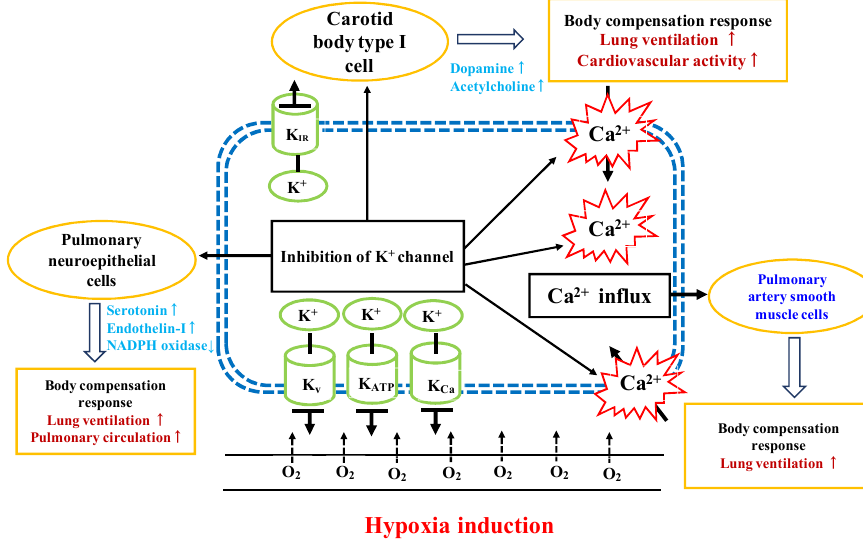
Figure 5. Postulated regulation pathway of oxygen-sensitive potassium channels on compensatory responses in acute hypoxia conditions.